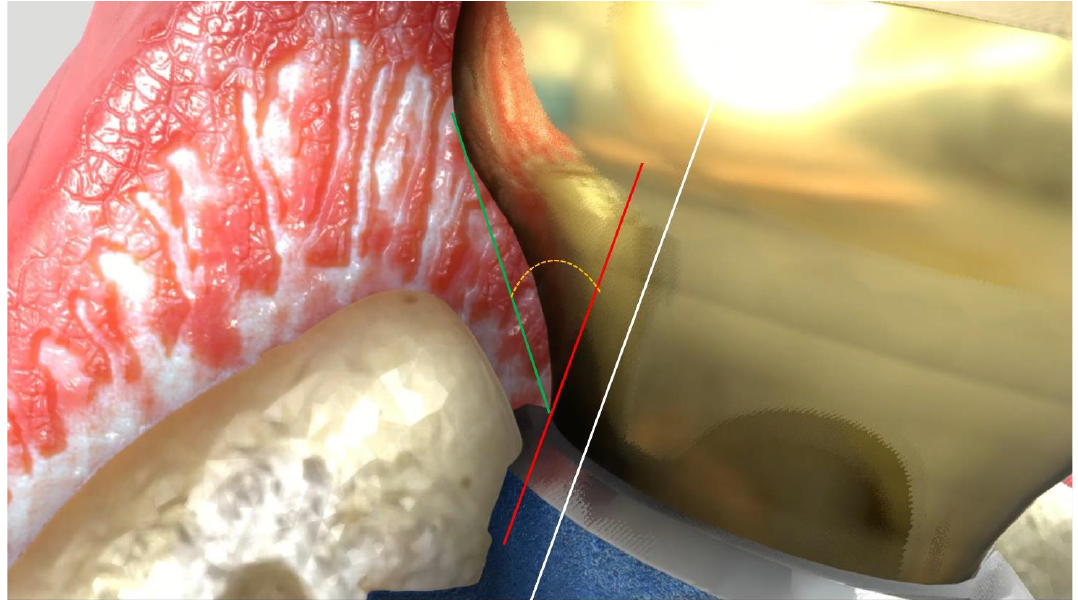
Figure 1. Emergence angle (EA) definition. White line: parallel to implant long axis. Red line: parallel to the white and tangential to the restoration from the implant to abutment connection. Green line: from implant to abutment connection point to the emergence profile. The angle of the intersection (yellow line) resulted in the emergence angle (EA).